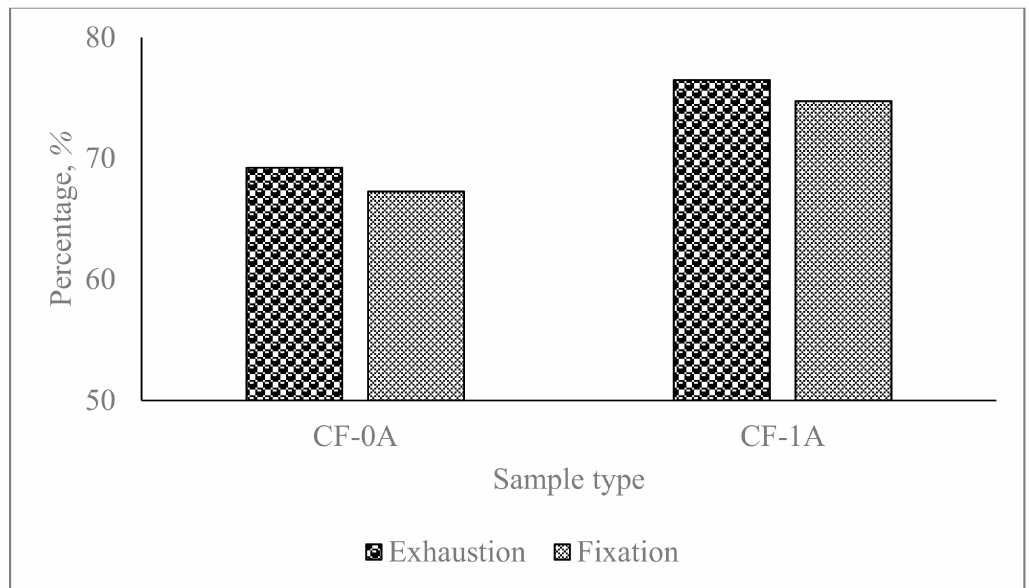
Figure 6. Dye exhaustion and fixation percentages of the dyed